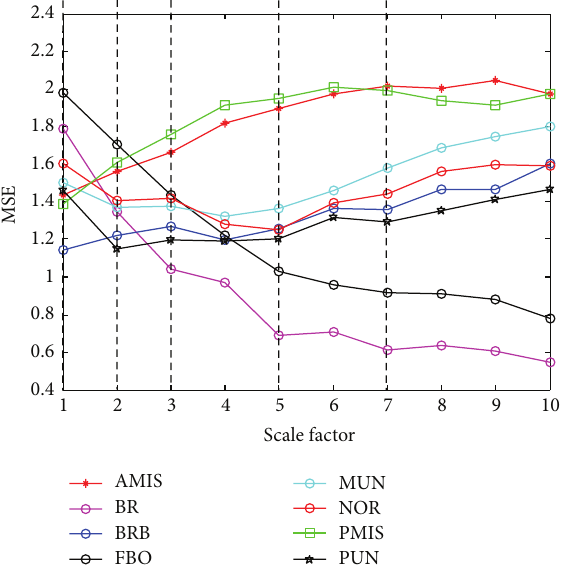
Figure 10: MSE of vibration signals.